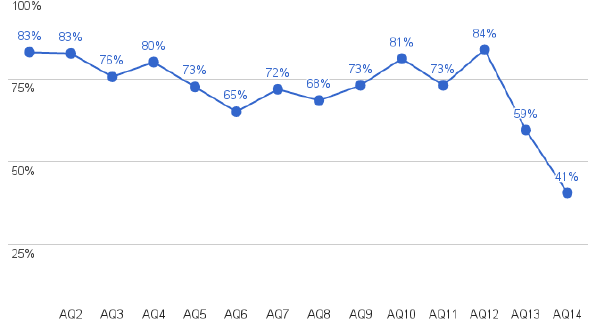
Fig 8. Participation rate during the semester Despite the decrease in participation rate between AQ12 and AQ13 from 84% to 59%, the proportion of students that executed the warm-up activity using the WhatsApp didn’t change in a significant way (as the graphs in Fig 9 shows), indicating that the type of activity didn’t influence the WhatsApp usage. In absolute numbers, six students used WhatsApp in the AQ12 and five in the AQ13. Out of the six students in the AQ12, three kept on using WhatsApp in the AQ13.